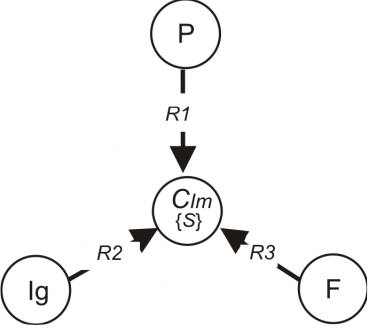
Figure 1. General structural scheme of connections between elements of the system: R1 — effect of flow cytophotometry parameters; R2 — effect of immunoglobulin parameters; R3 — effect of phagocytosis parameters on the human immune system CIm .